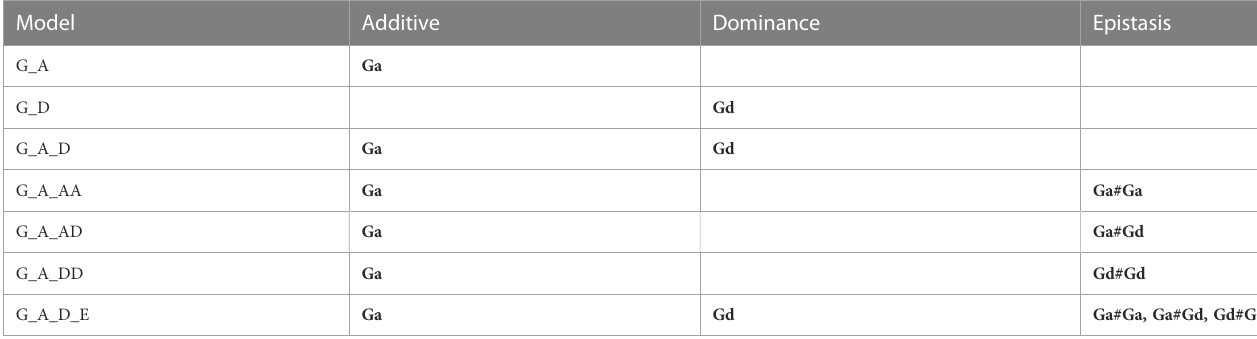
TABLE 1 Summary of extended GBLUP models with different relationship